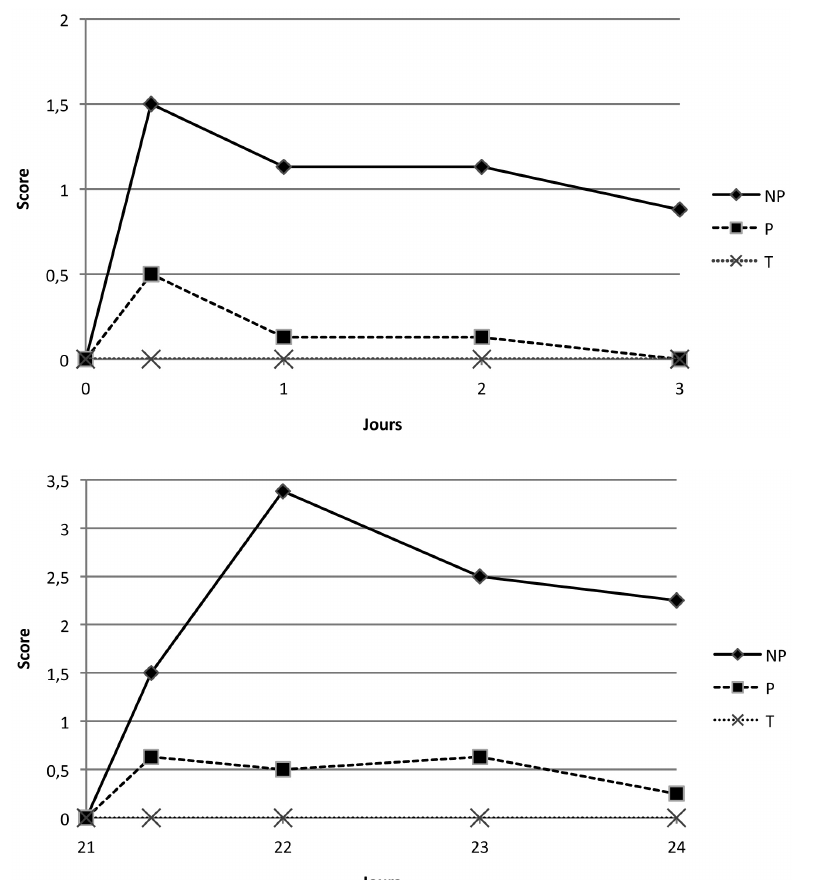
Figure 4. – Moyenne des SCGL suite à la seconde immunisation pour les groupes NP, P et